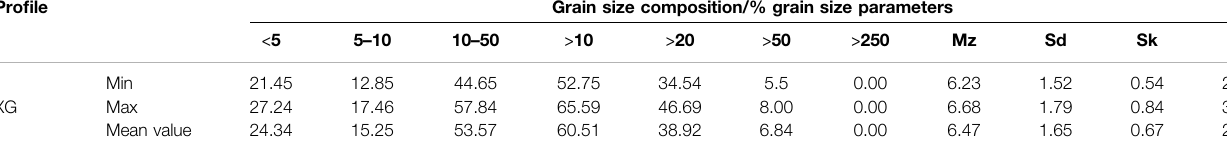
TABLE 5 | Grain size composition and Grain size parameters of XG pro fi le. Pro fi